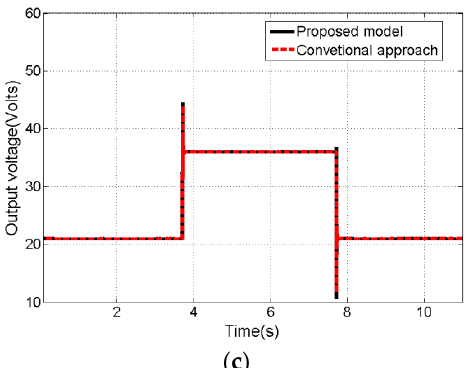
Figure 6. Curves for a DR value change from 30% to 60% to 30%: ( a ) proposed model and experimental output voltages, ( b ) experimental and conventional approach output voltages, and ( c ) proposed and conventional approach output voltages.